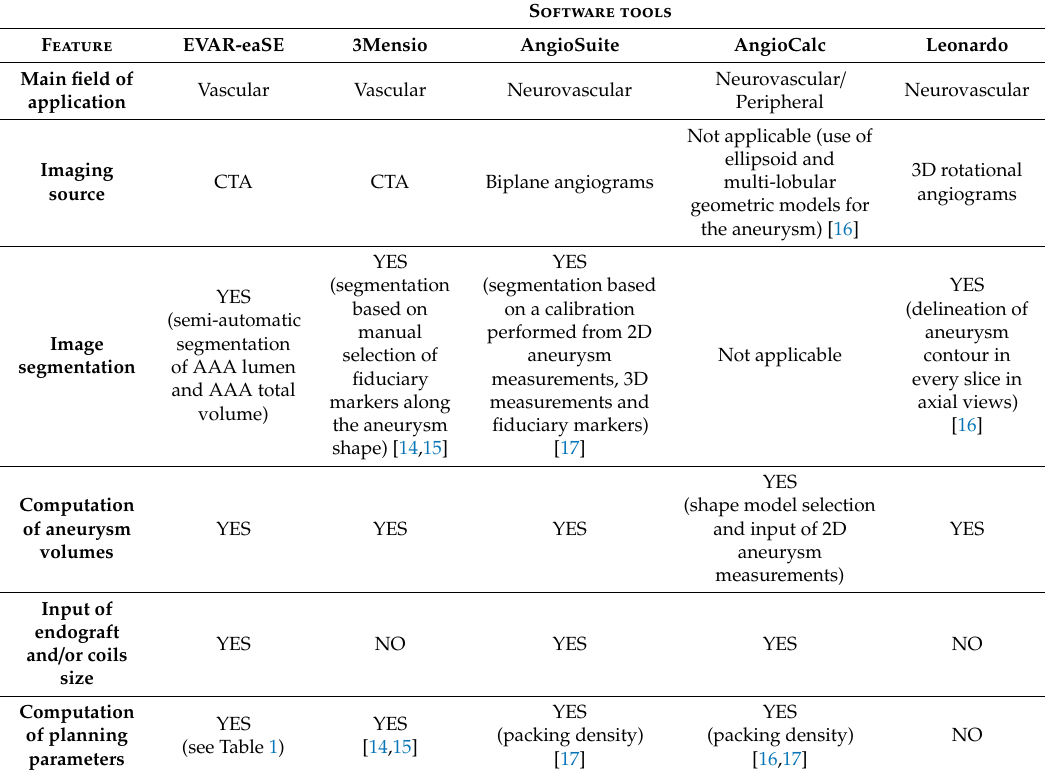
Table 6. Comparative table of EVAR-eaSE with other available software tools. S oftware